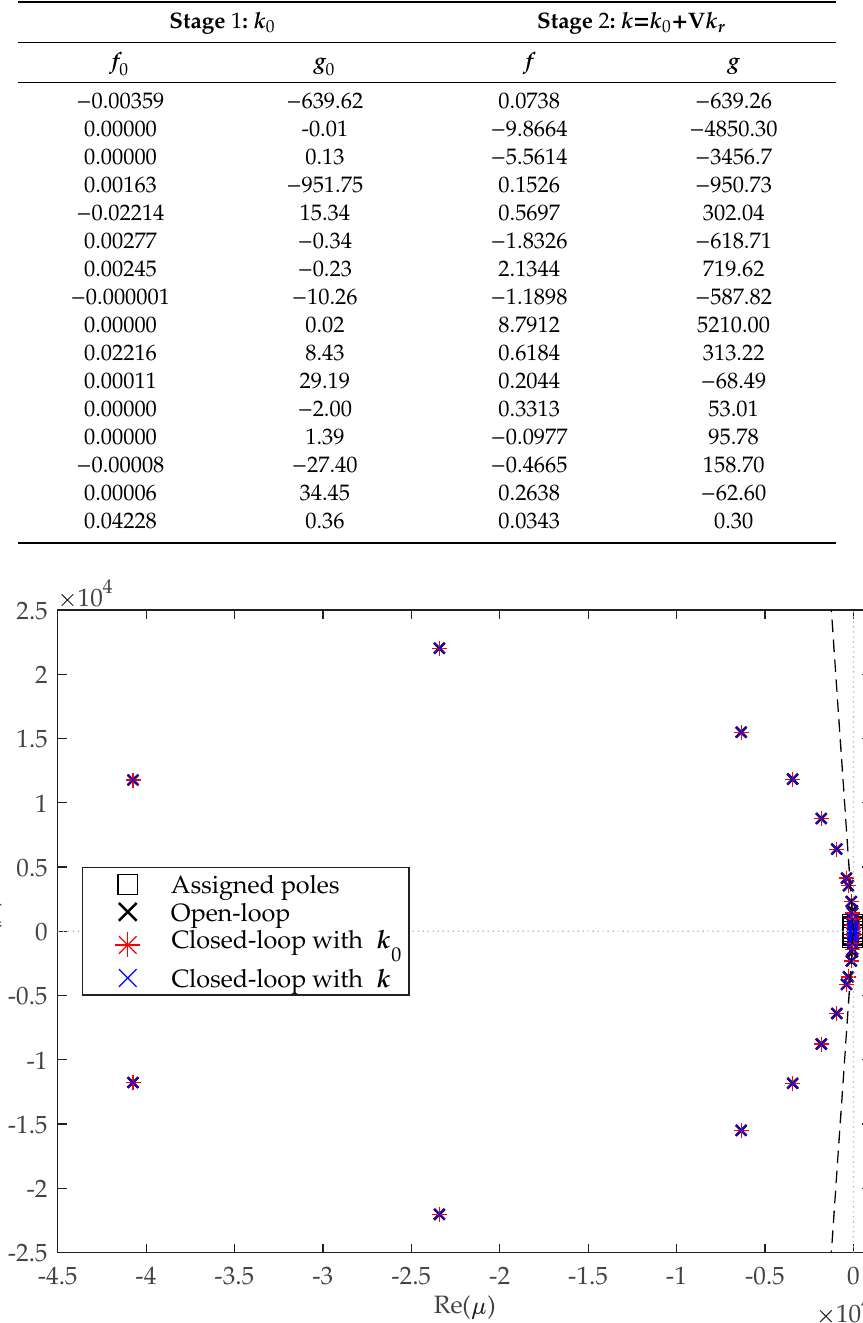
Figure 12. Pole map of the four-bar linkage: low frequency detail (test-case 4).